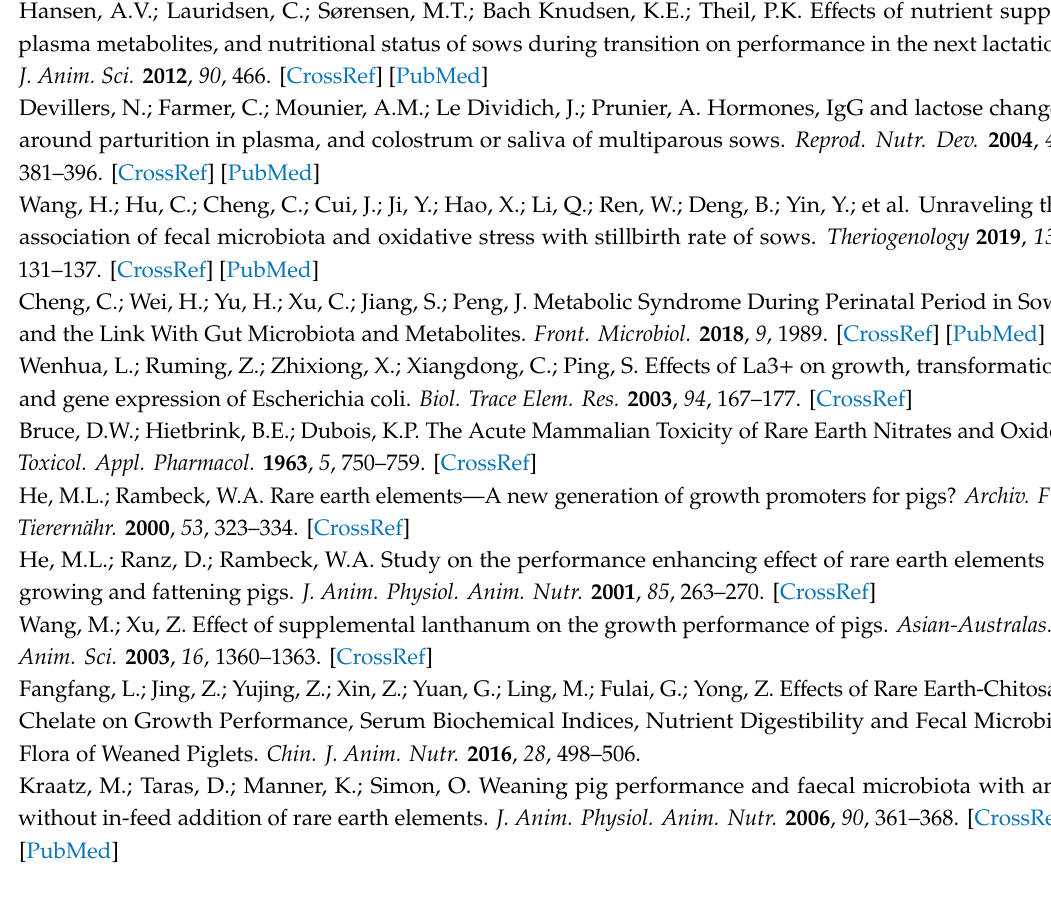
Figure S1: Non-metric multidimensional scaling analysis (NMDS, Bray–Curtis distance) plot of (A) the sows and (B) their piglets. n = 8 per group, Figure S2: Abundant phylum in fecal microbiota of (A) the sows and (B) their piglets. n = 8 per